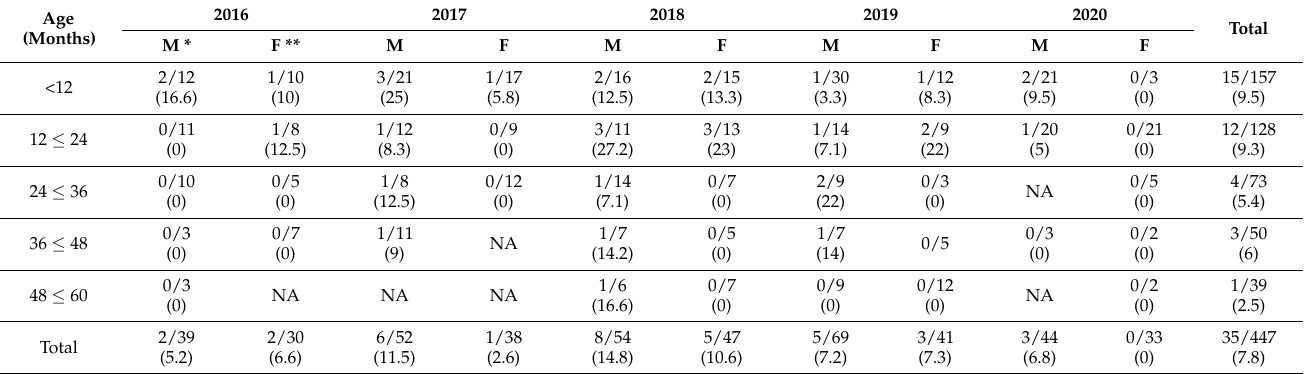
M * refers to male, while F ** refers to female, but NA is meaning not applicable.